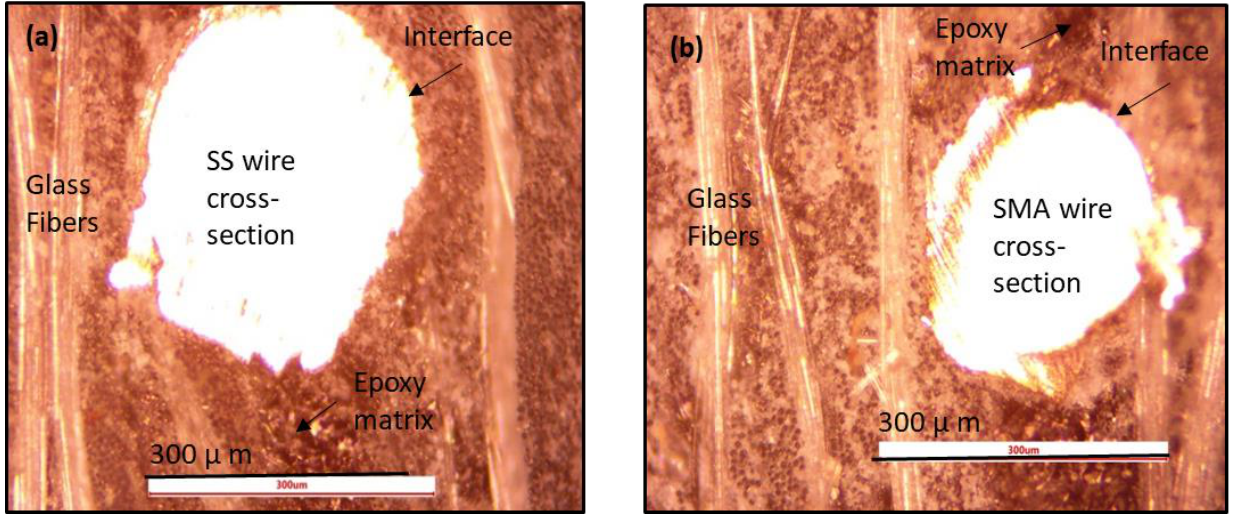
Figure 7. Optical micrographs of cross-section of hybrid composites after treatment of wires: ( a ) SS/GFRP hybrid composite; ( b ) SMA/GFRP composite.